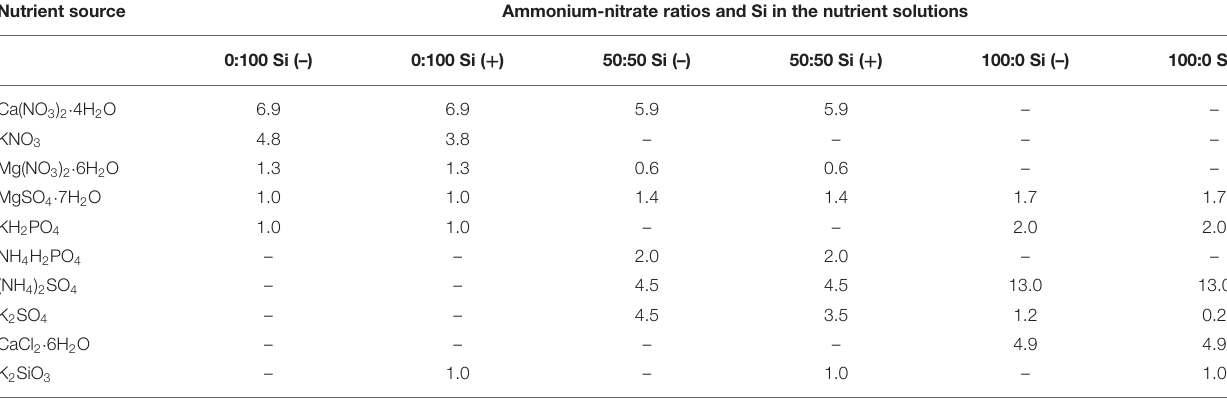
TABLE 1 | Nutrition compositions (me · L − 1 ) for treatment solutions used in the present experiment. Nutrient